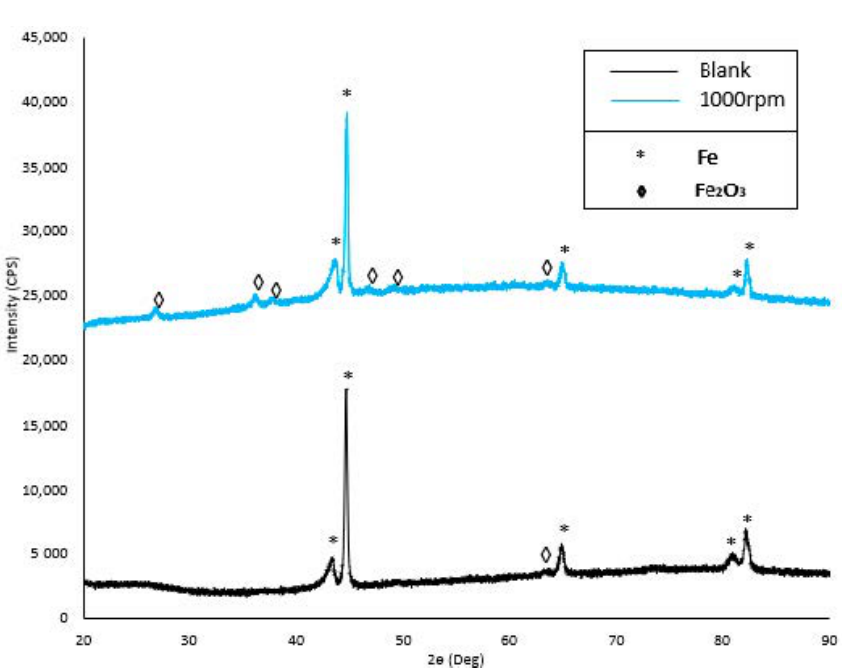
Figure 13. XRD fitting spectrum obtained from corrosion product layer at 1000 rpm after 24 h.